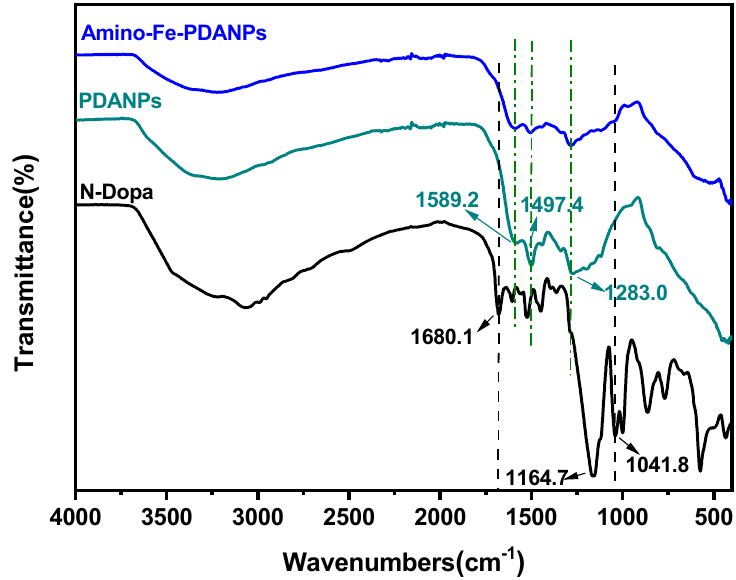
Figure 4. FTIR spectra of N-Dopa, PDANP S and amino-Fe-PDANP S.